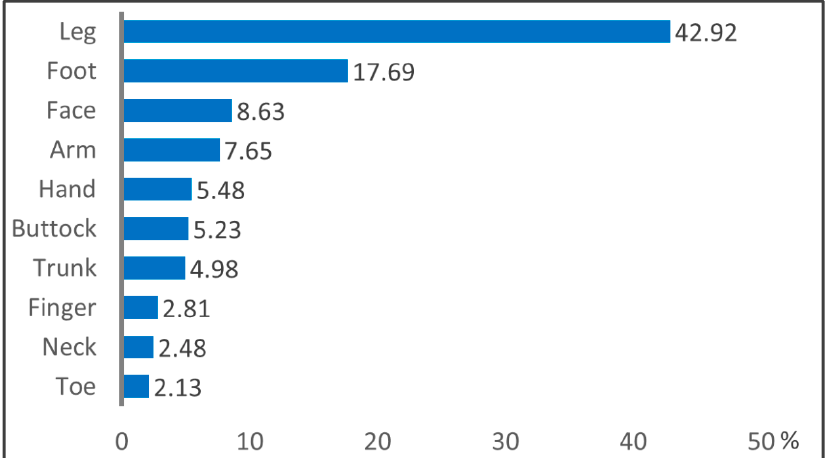
Figure 2. The proportion of cellulitis in different parts of the body. The leg and foot are the most prone to cellulitis after acupuncture, accounting for 42.95% and 17.69%, respectively; on the other hand, the trunk, fingers, and neck feature the lowest proportion.